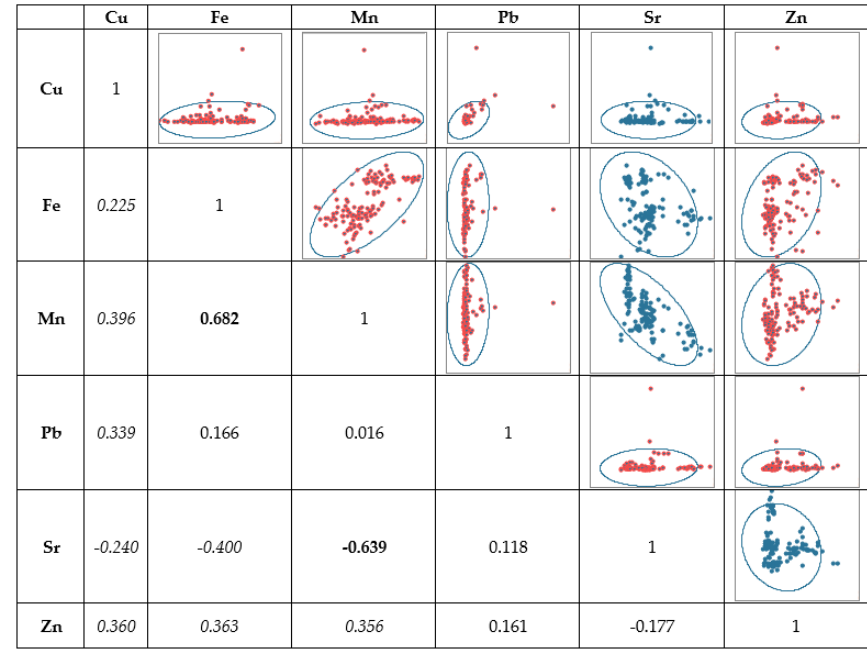
Figure 1. Scatterplot matrix on multivariate correlations.